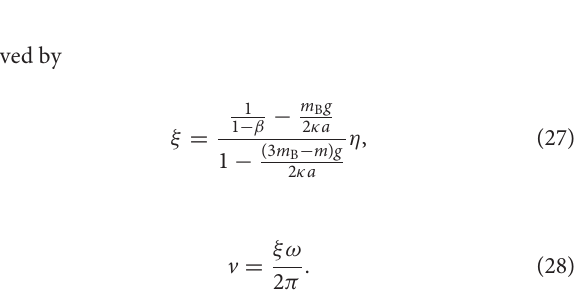
FIGURE 11 | Connection of the solution sets: (A) Source-wave gaits ( k N ( k 1, N ) projected onto the ˆ ψ N − 1 N = −